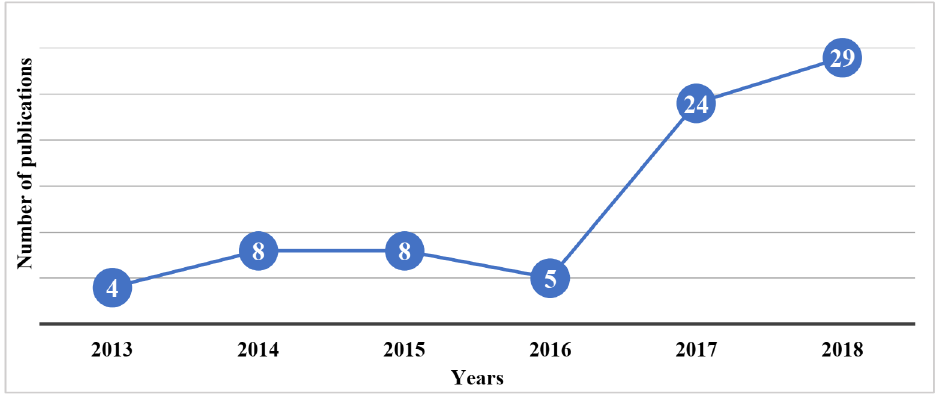
Figure 6. Publications over the years. Figure 7 further analysed this trend by differentiating between ML and DL terms. Papers were highlighted by focusing on the DL approach or those applying DL methods.